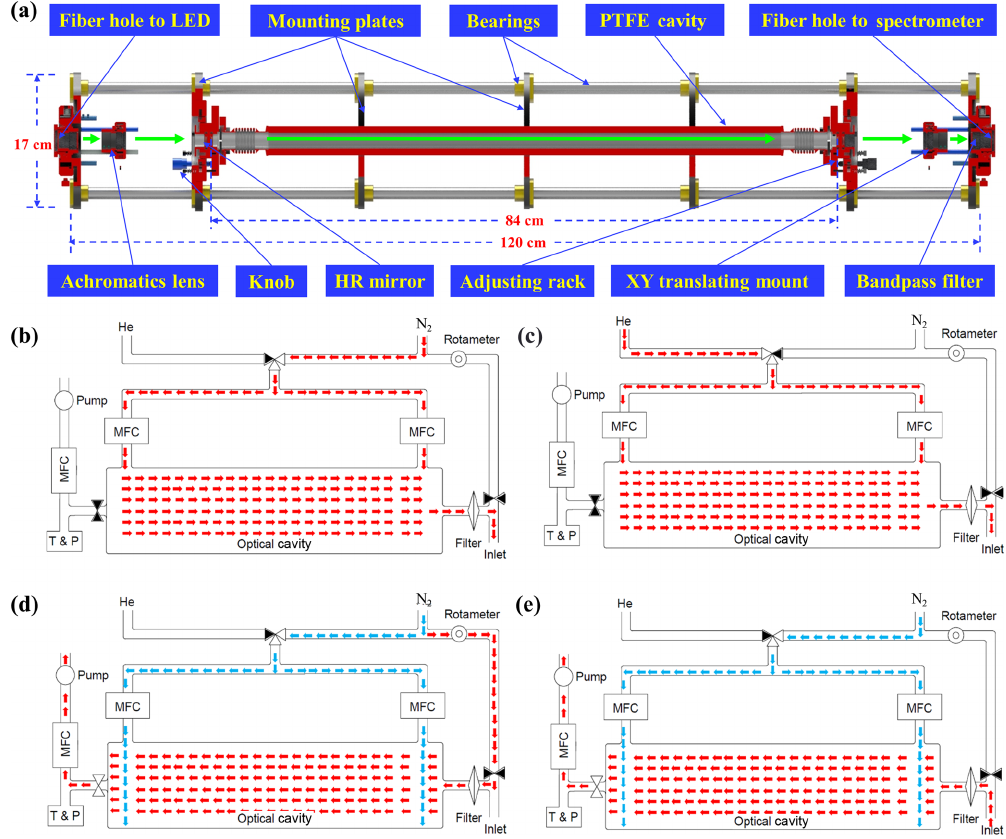
Figure 1. (a) Optical cavity module of the IBBCEAS system. Schematic layout of the instrumental flow system depicting four working modes: (b) N 2 mode, (c) He mode, (d) reference mode, and (e) sample mode. The N 2 mode and He mode are used to calibrate mirror reflectivity and the reference mode and sample mode are used to calculate the concentrations of trace